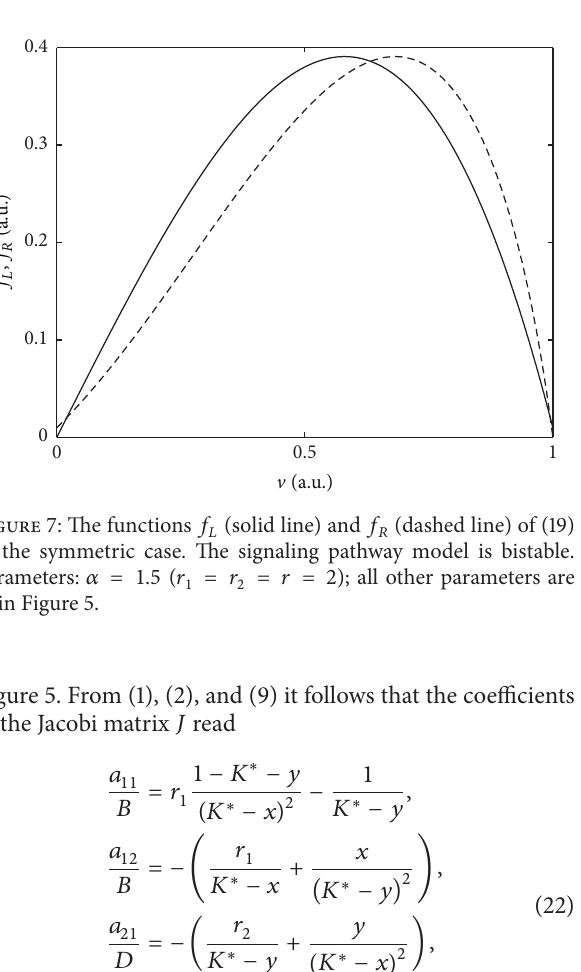
Figure 6: Illustration of the saddle-node bifurcation using the cubic fixed point equation (19). The functions 𝑓 𝐿 (solid line) and 𝑓 𝑅 (dashed line) of (19) are plotted versus V at the saddle-node bifur- cation point in which the states 𝑥 (high) and 𝑦 (low) emerge or dis- appear. Parameters: 𝛼 = 0.8 ; all other parameters are as in Figure 5.